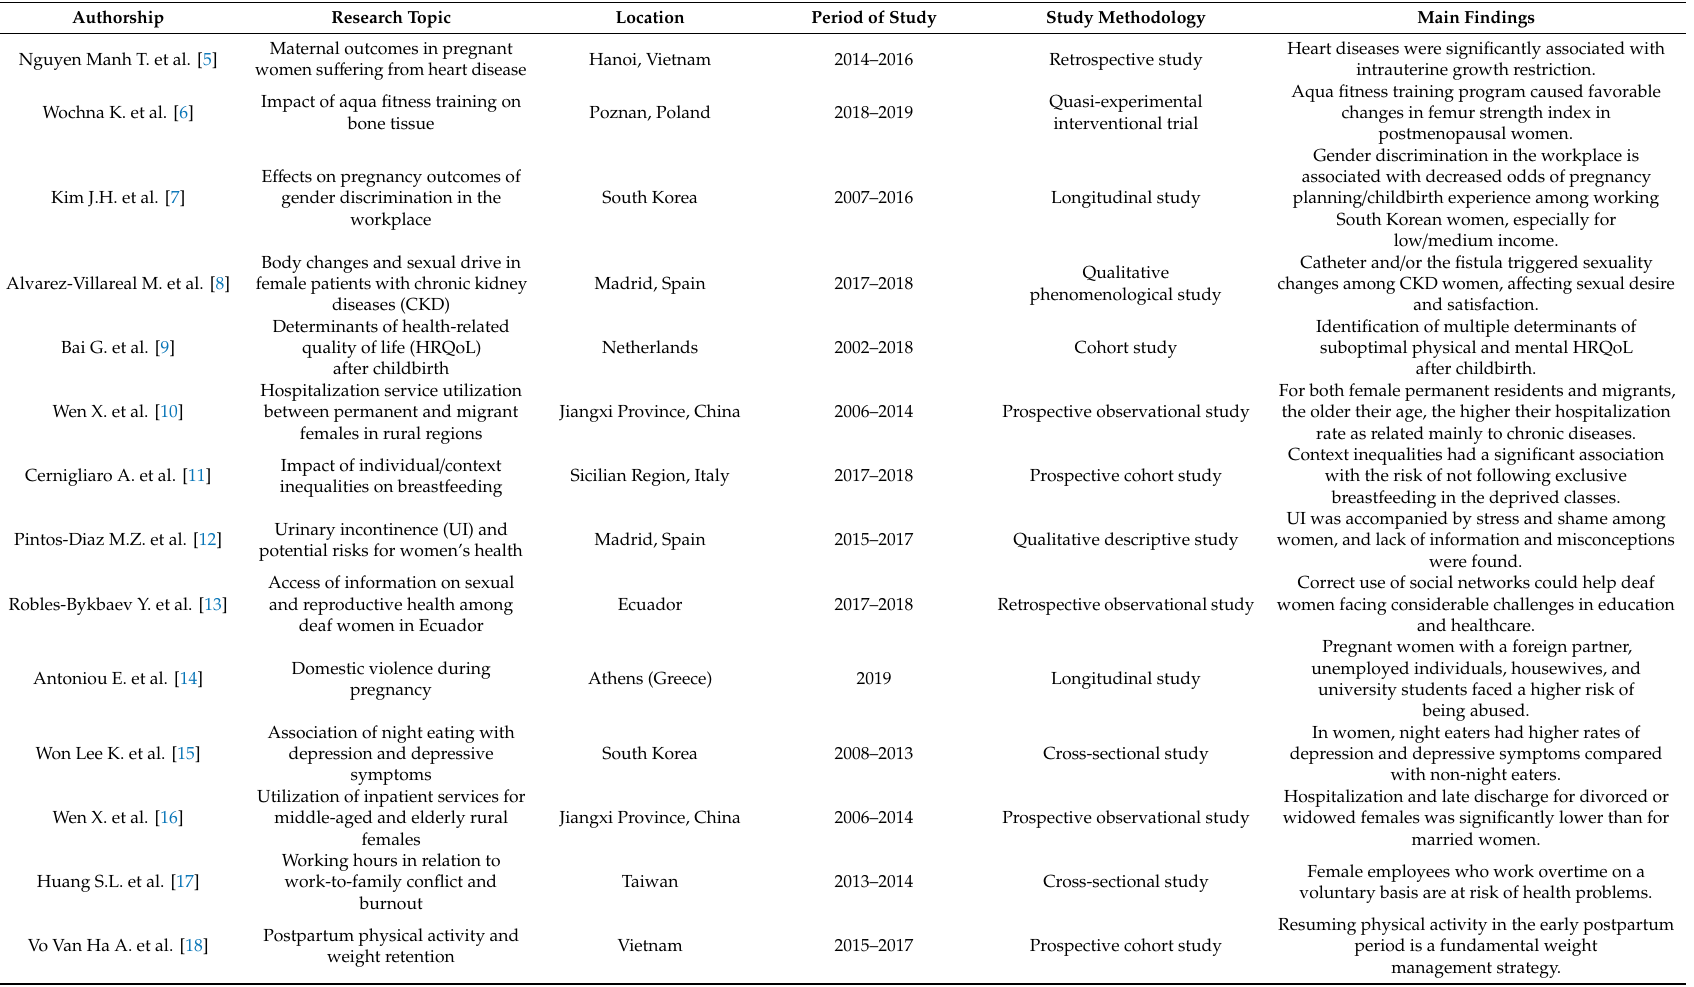
Table 1. Description of the manuscripts published in the Special Issue “Potential Risks and Factors of Women’s Health Promotion” in chronological publishing